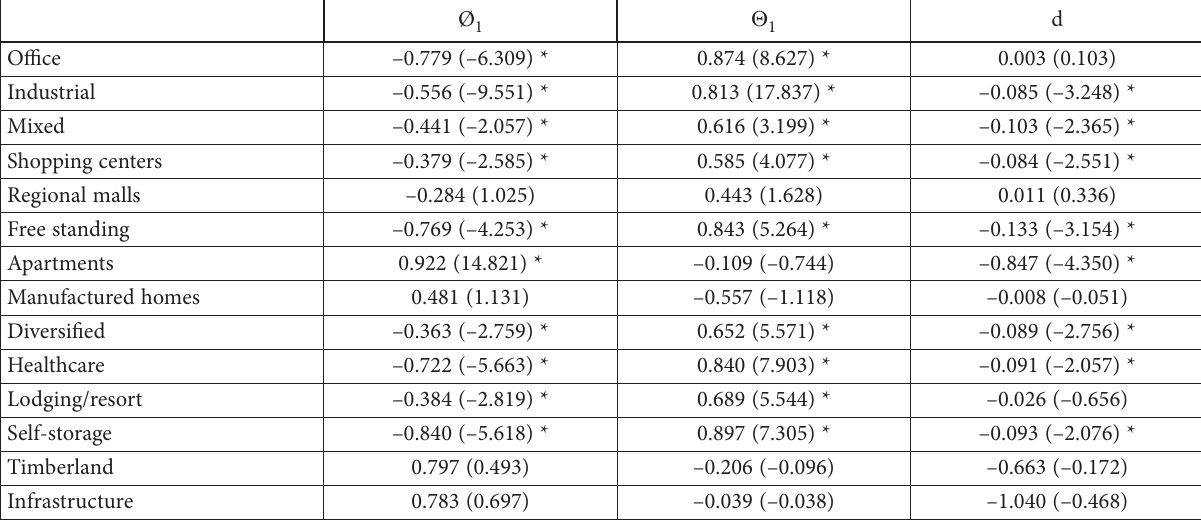
Table 9. Long memory in REITs subsectors using ARFIMA